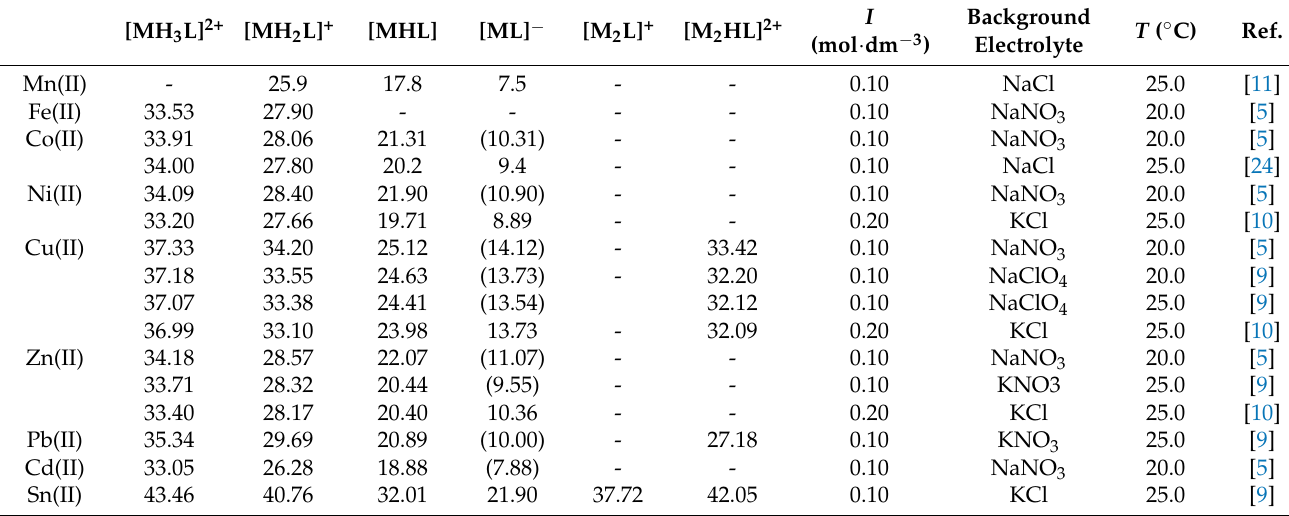
Table 4. Overall complex-formation constants (log β ) of DFOB with divalent transition metal ions under different experimen- tal conditions. The constants in parentheses correspond to the formation of the 1:1 complex of M(II) with DFOB protonated at its amino group and therefore refer to the equilibrium: M 2+ + HL 2 − = MHL.